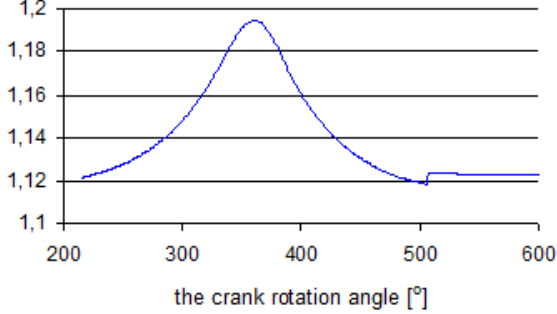
Fig. 4. The quotient values of temperature and pressure for different types of air change in comparison to adiabatic process at piston location in TDC